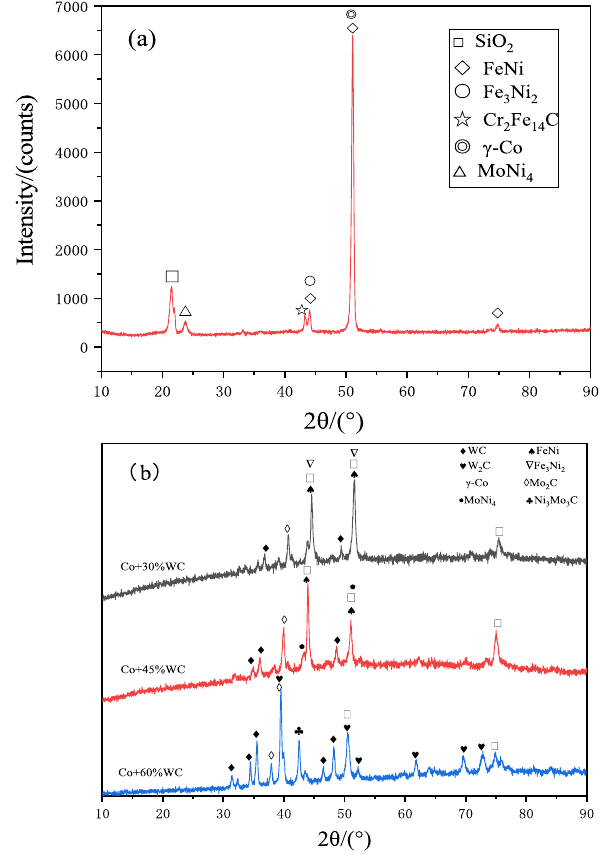
Figure 4: XRD spectra of PTA coatings. ( a ) Co coating; ( b ) Co + WC